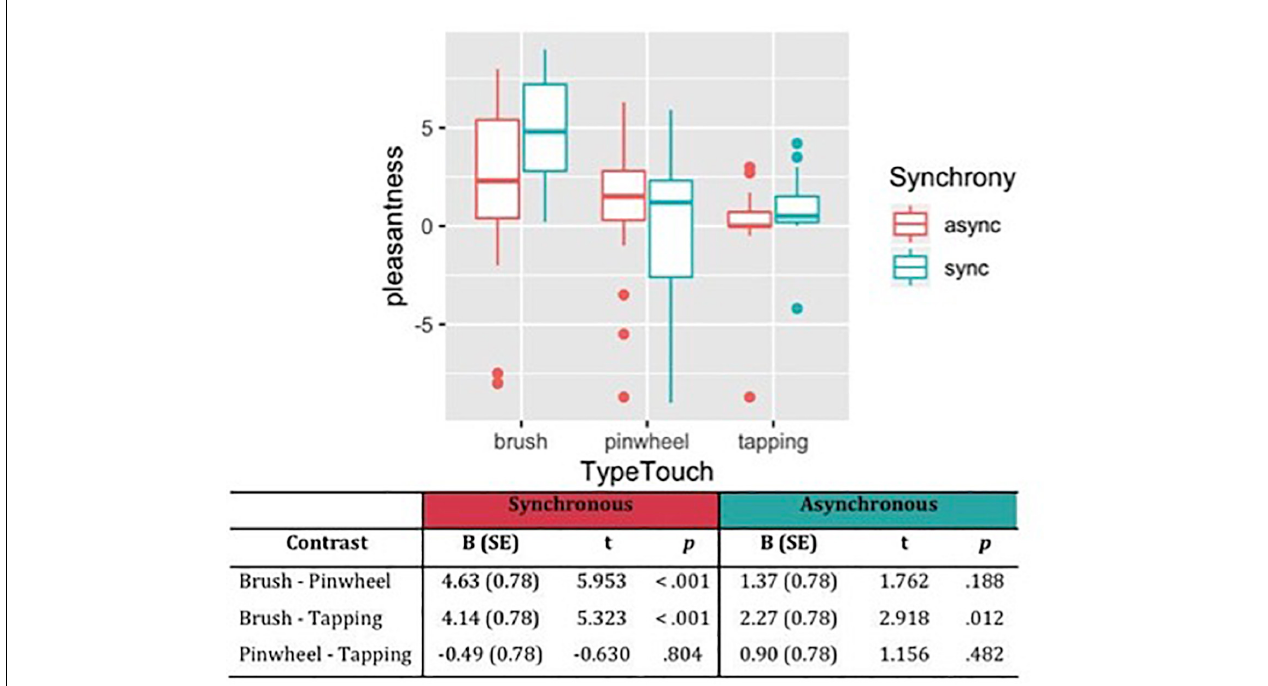
FIGURE 2 | Subjective pleasantness of tactile stimulations measured on VAS scale from –10 (very unpleasant) to +10 (very pleasant). Contrasts between different types of touch have been reported, showing that brush stroking was perceived as the most pleasant stimulation, in particular in the synchronous